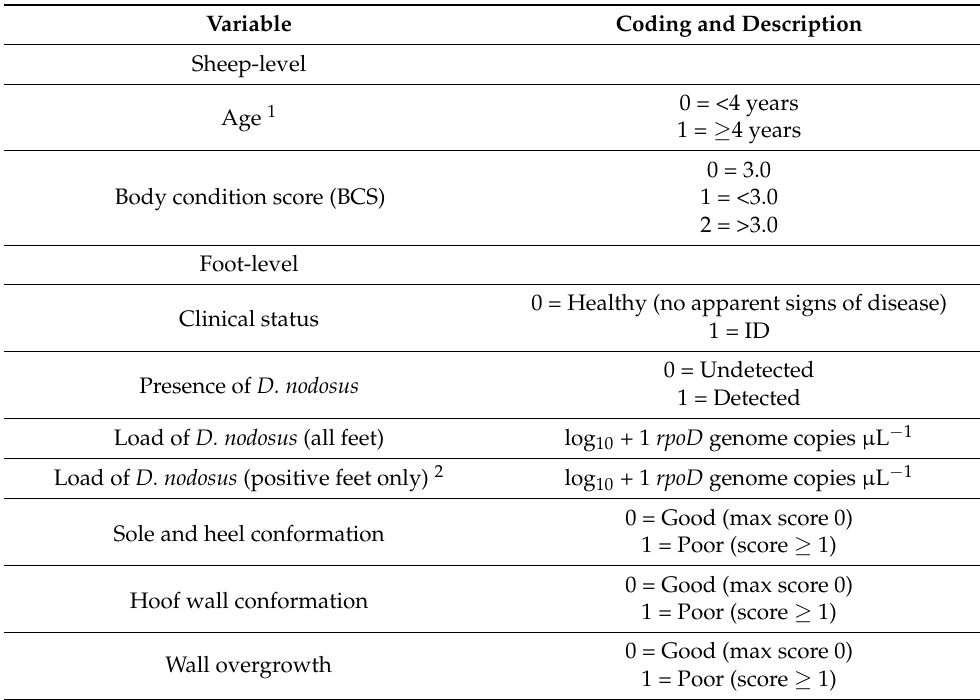
Table 3. Description and coding of sheep- and foot-level variables considered in